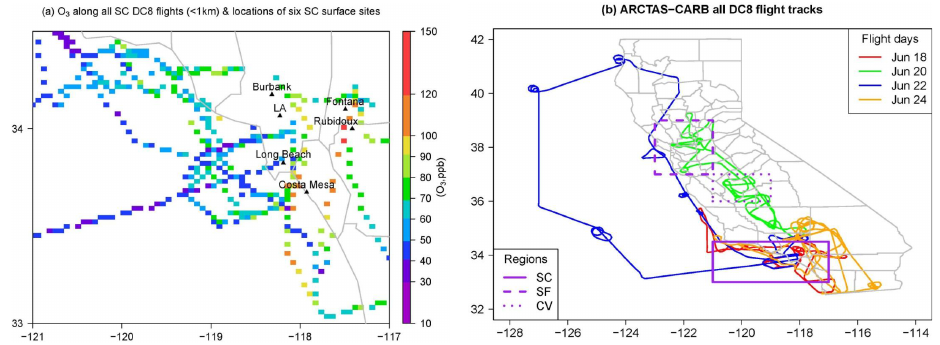
Figure 1 (a) Observed O 3 along all SC flight path below 1km, the locations of six SC surface sites are overlaid; (b) DC-8 flight paths on June 18, 20, 22, 24 during ARCTAS-CARB period, and the defined study regions.